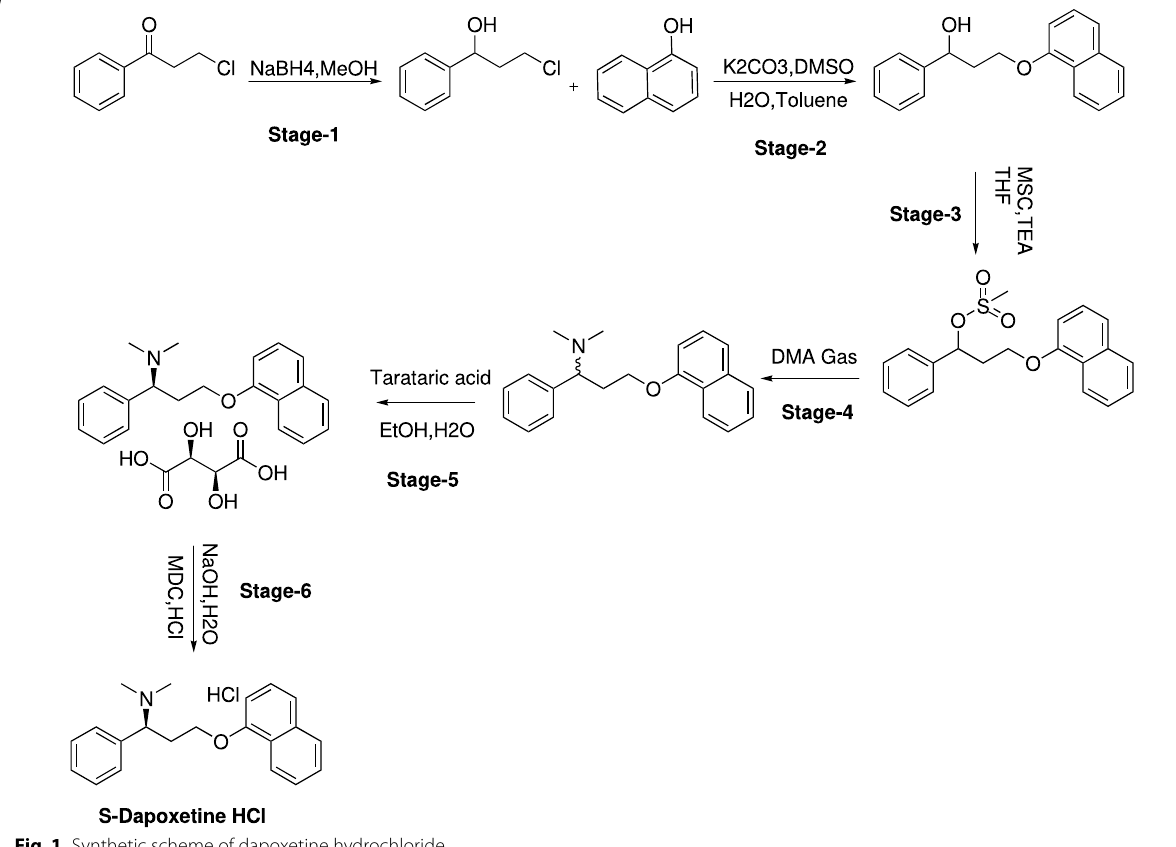
Fig. 1 Synthetic scheme of dapoxetine